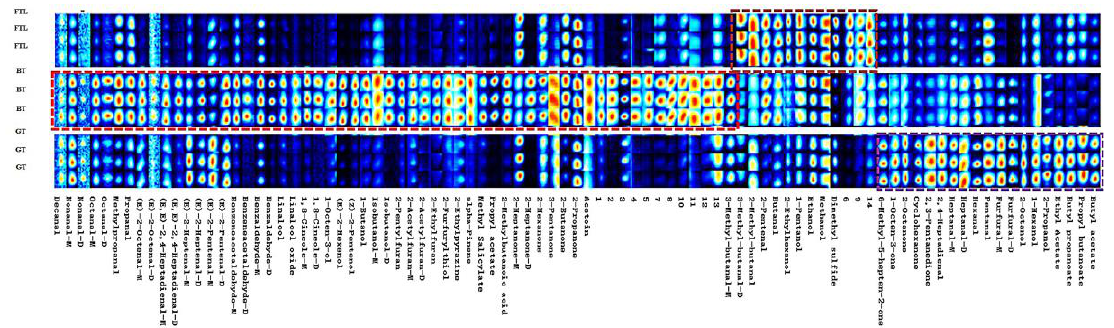
To show the changing regularities and relative content of the volatile compounds of